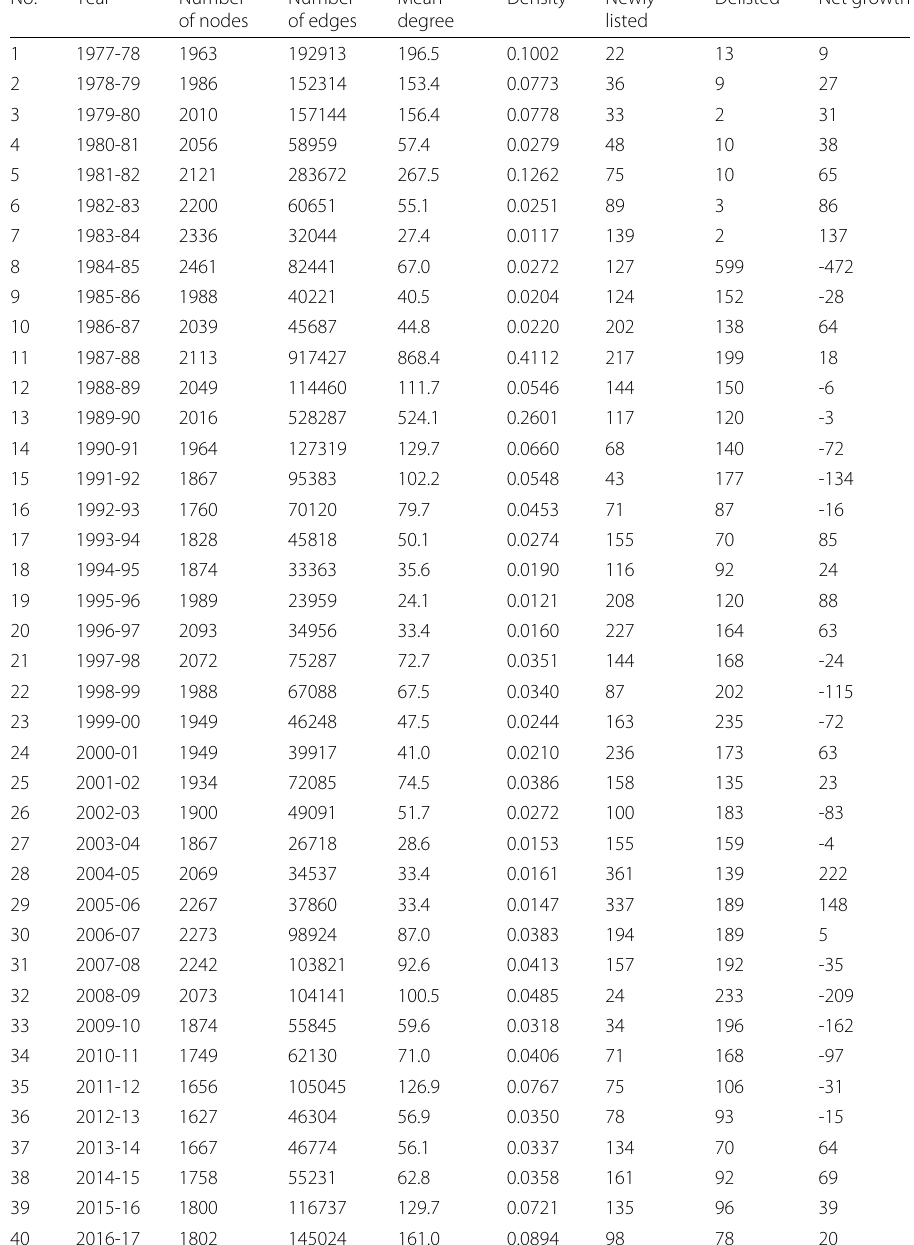
Table 2 Statistic summary of 40 constructed